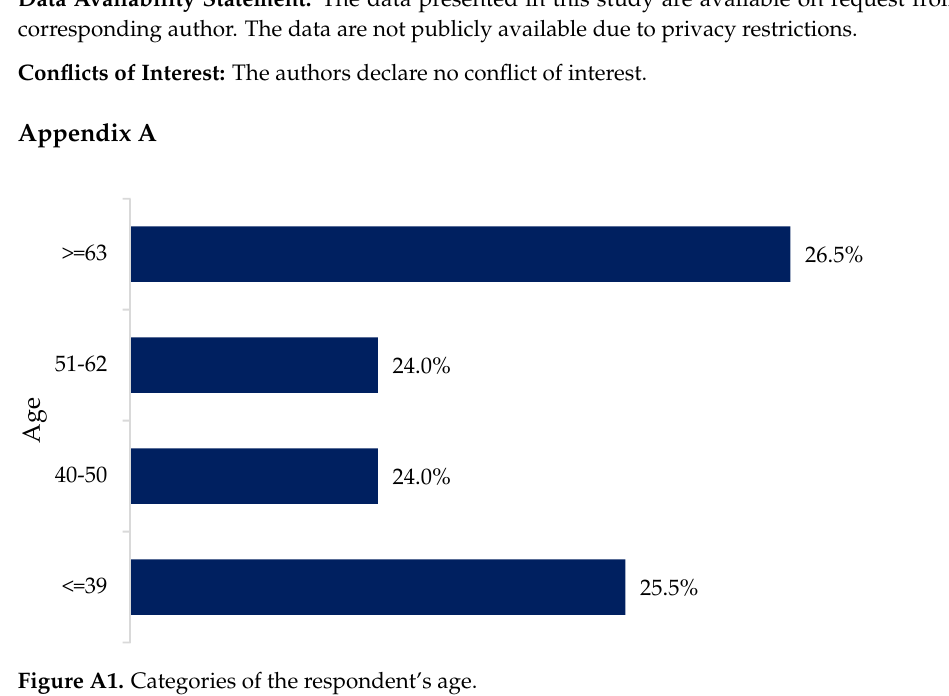
Figure A1. Categories of the respondent’s age.